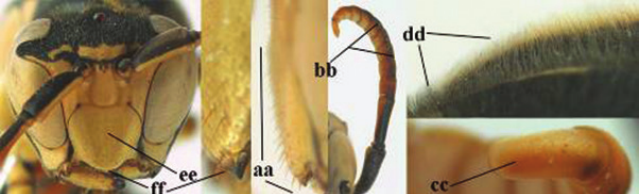
28 Ventral half of clypeus distinctly depressed (a) and with distinct lateral ridges (b); dorsal length of apical antennal segment about 3.0 times its width (c); frons with a distinct longitudinal depression medially (d); sternites III-VII usually with transverse yellow band basally (e; visible with sternites sufficient- ly extruded) and last sternite often partly yellow (f); apical half of antenna usually distinctly darkened dorsally (g); clypeus more or less truncate